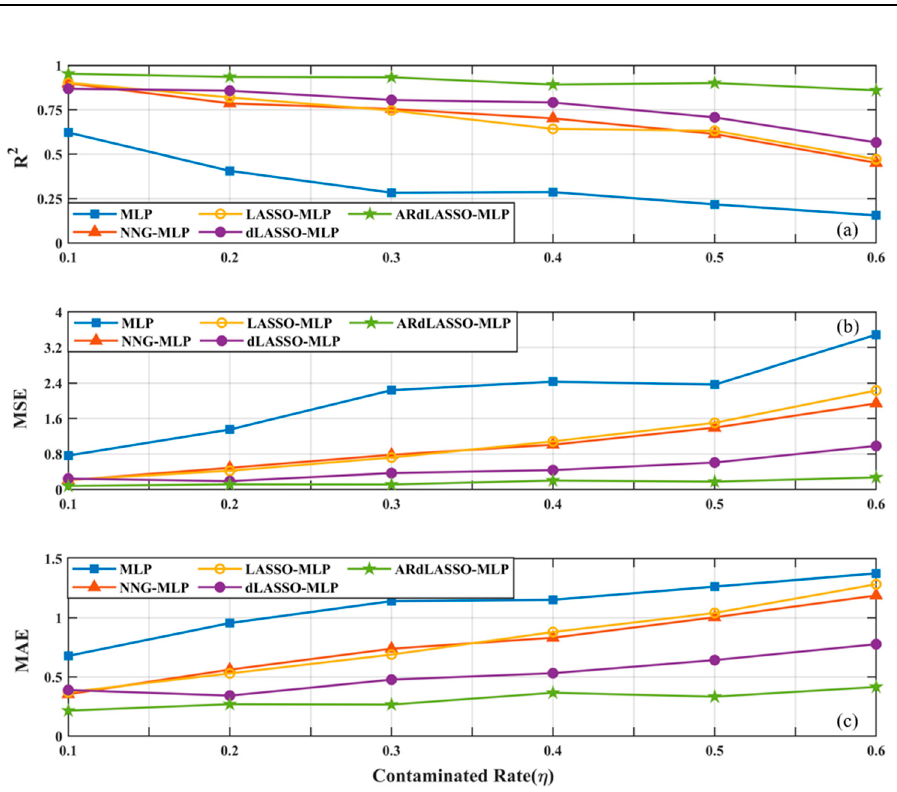
Figure 4. Performance comparison with different 𝜂 : ( a ) R 2 ; ( b ) MSE; ( c )